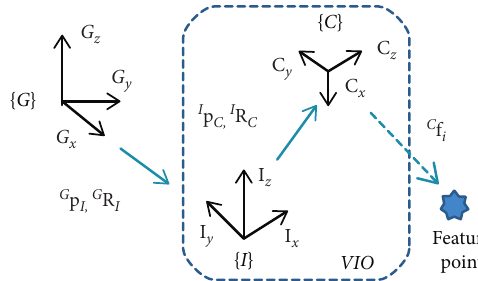
Figure 2: Coordinate system of { A }. The VIO coordinate system is assigned as in Figure 2 frame { I }. The VIO system tracks the transformation of { I }